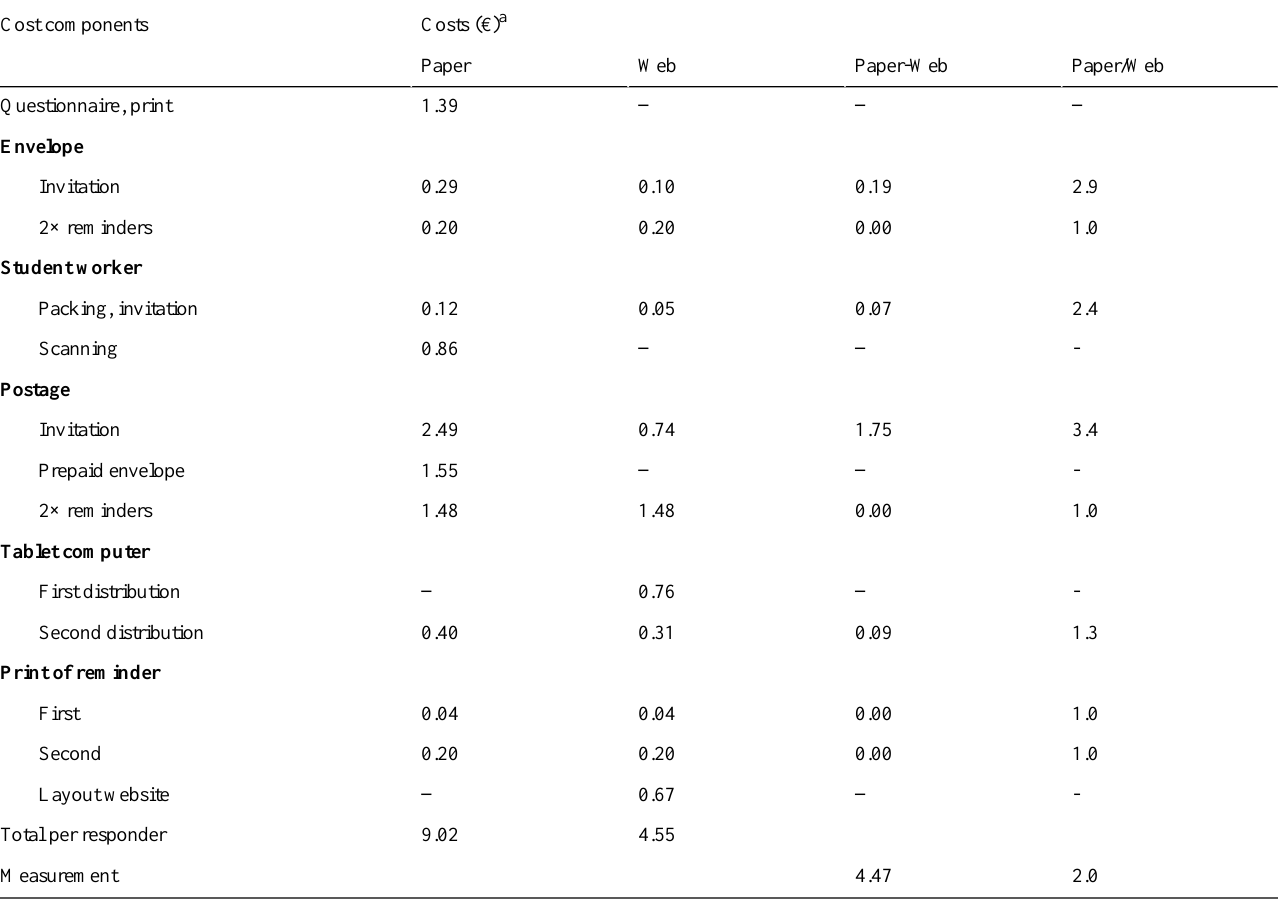
Table 3. Costs (2011 prices) per respondent for distribution and collection of the Danish 2011 NordChild questionnaire survey.